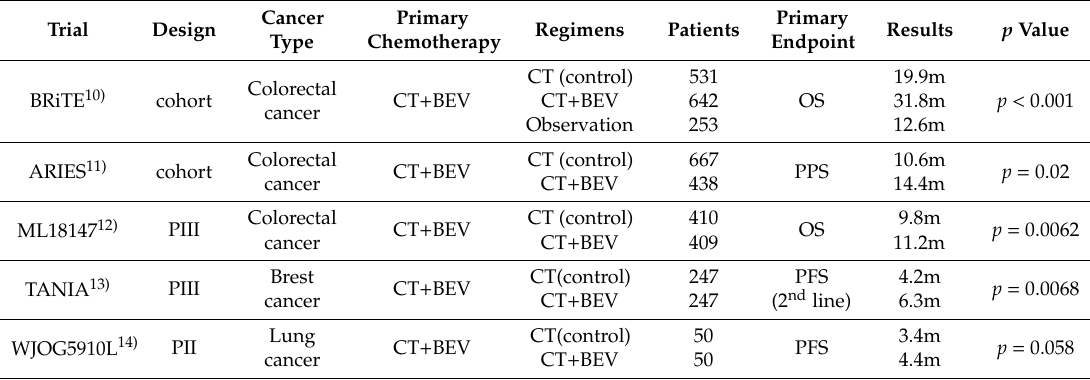
Table 1. Previous Clinical Trials of Bevacizumab beyond